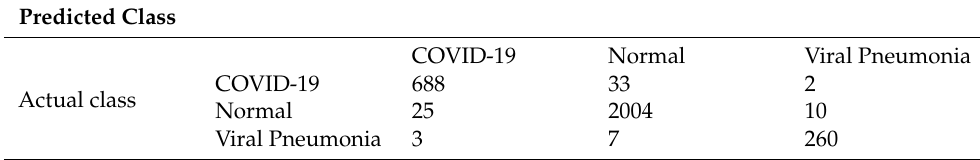
Table 7. Testing confusion matrix of the proposed CovidDetNet model.